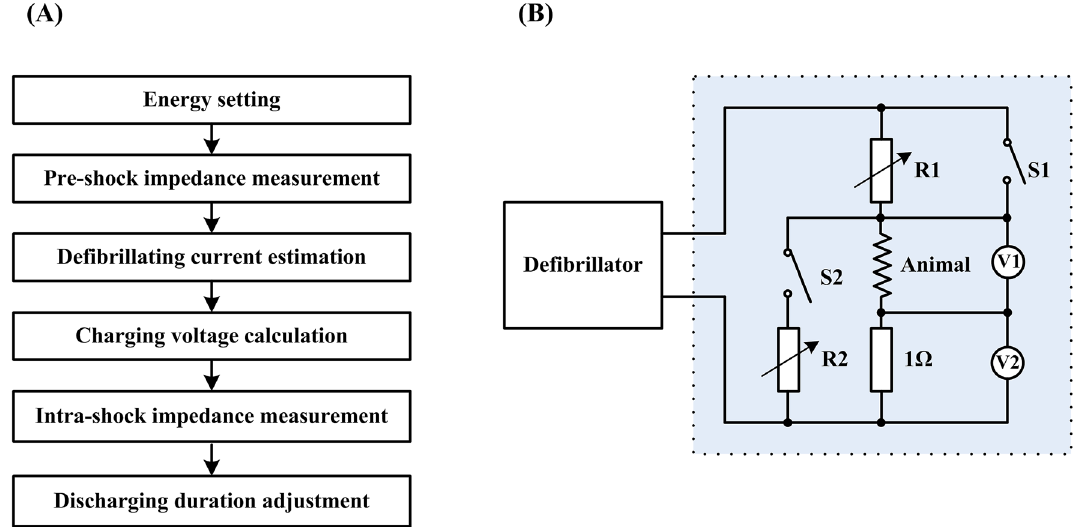
Figure 1. ( A ) Implementation of current-based defibrillation; ( B ) setup for different pathway impedance